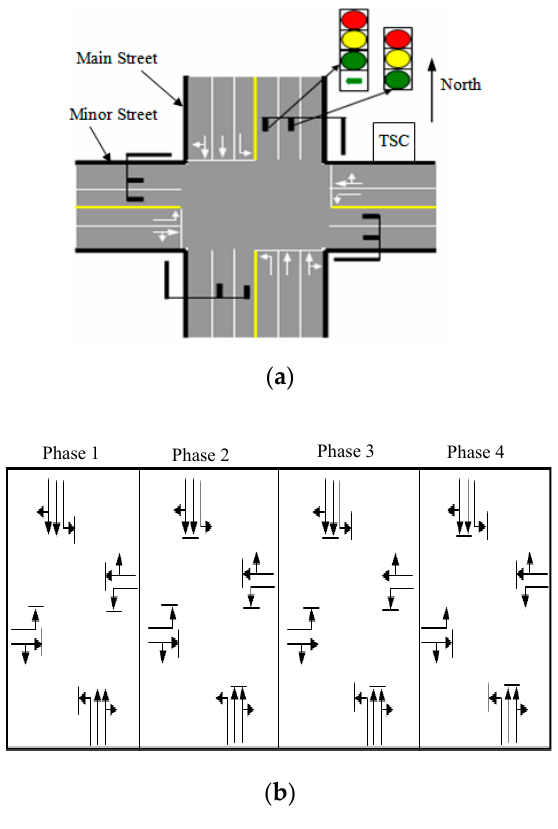
Figure 1. Traditional four-leg at-grade intersection model and its signal phase diagram: ( a ) Four-leg at-grade intersection model. ( b ) Intersection signal control phases. TSC: tra ffi c signal